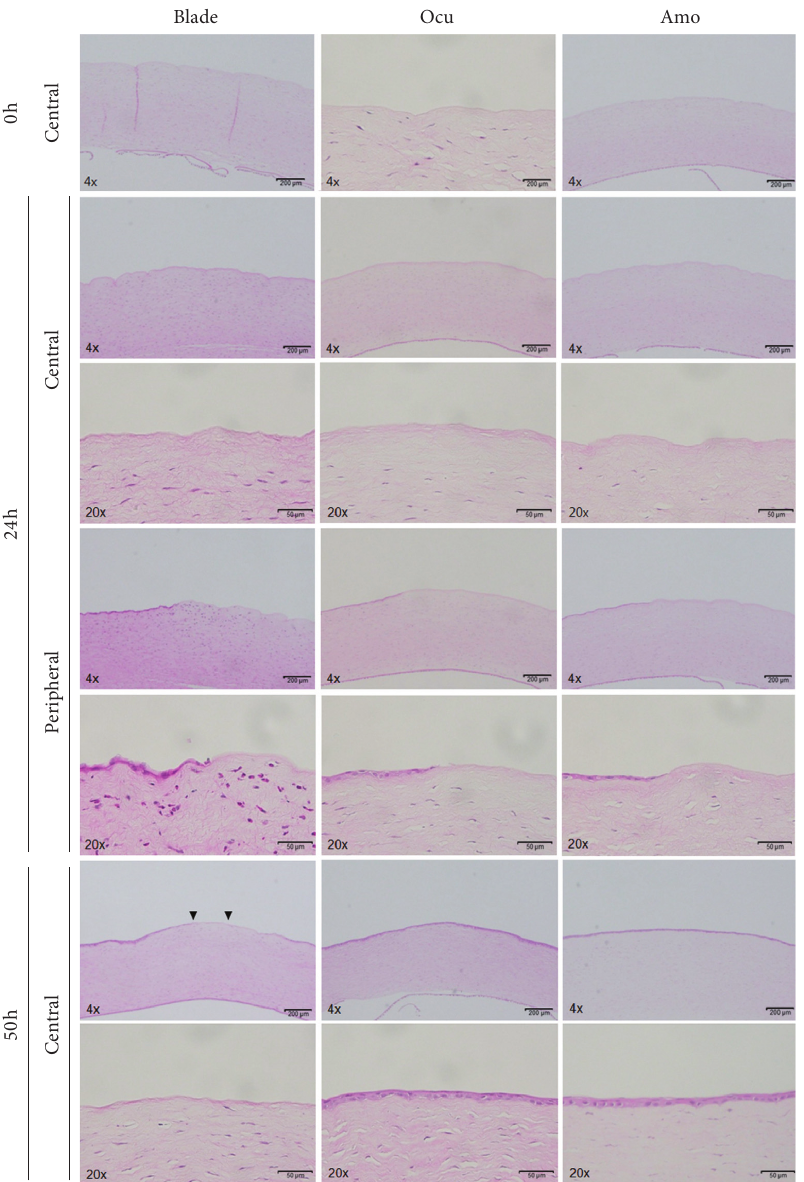
Figure 4: Hematoxylin and eosin staining immediately and at 24 and 50 hours after epithelial removal in the three groups.